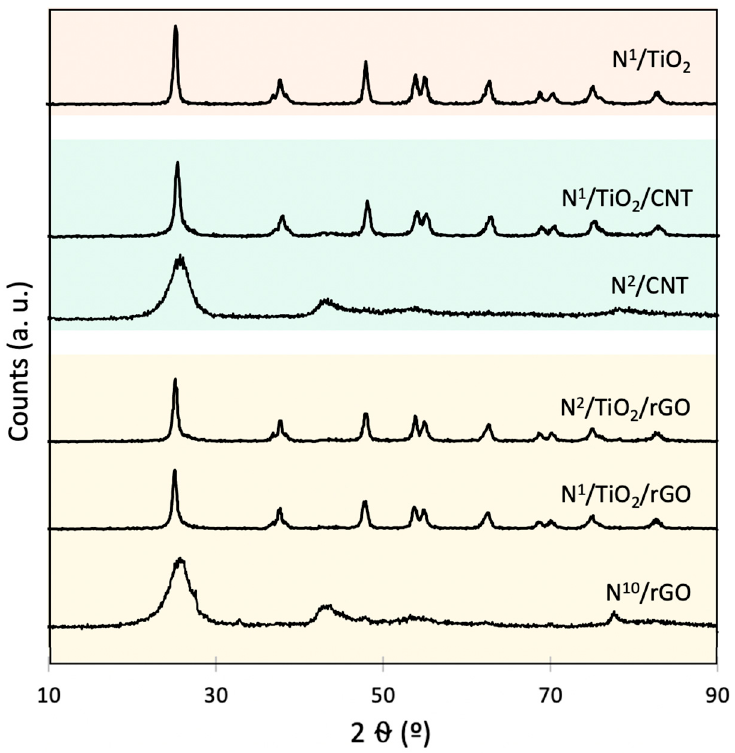
Figure 4. XRD diffractograms of different synthesized N-doped photocatalysts and supports. Table 4. Results of the characterization of different N-doped TiO 2 -based photocatalysts and supports.